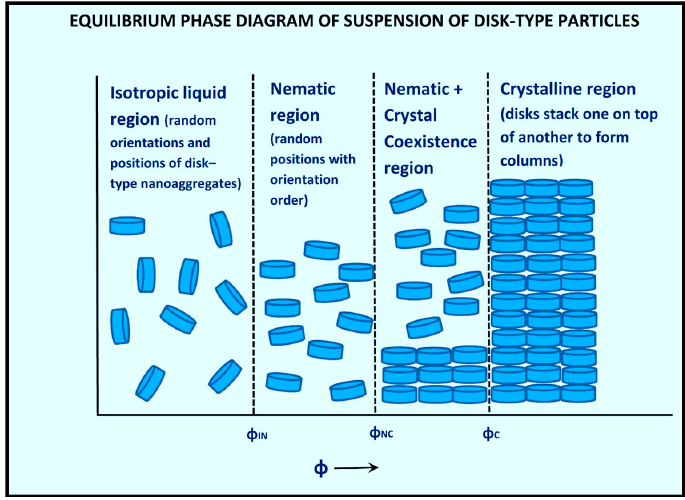
φ under equilibrium